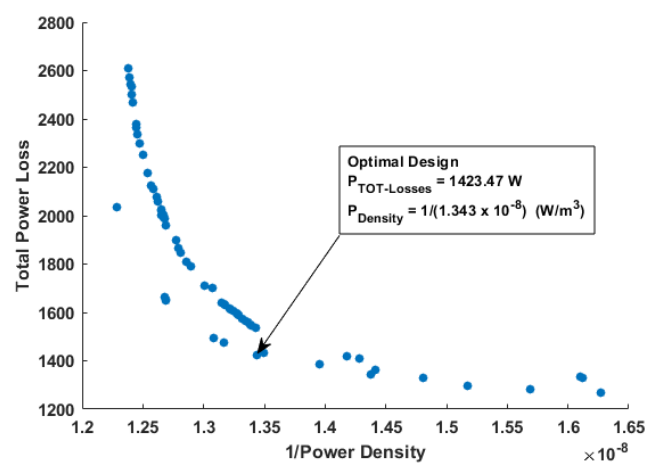
Figure 9. the final Pareto front with the final optimum point. Figure 9. The final Pareto front with the final optimum